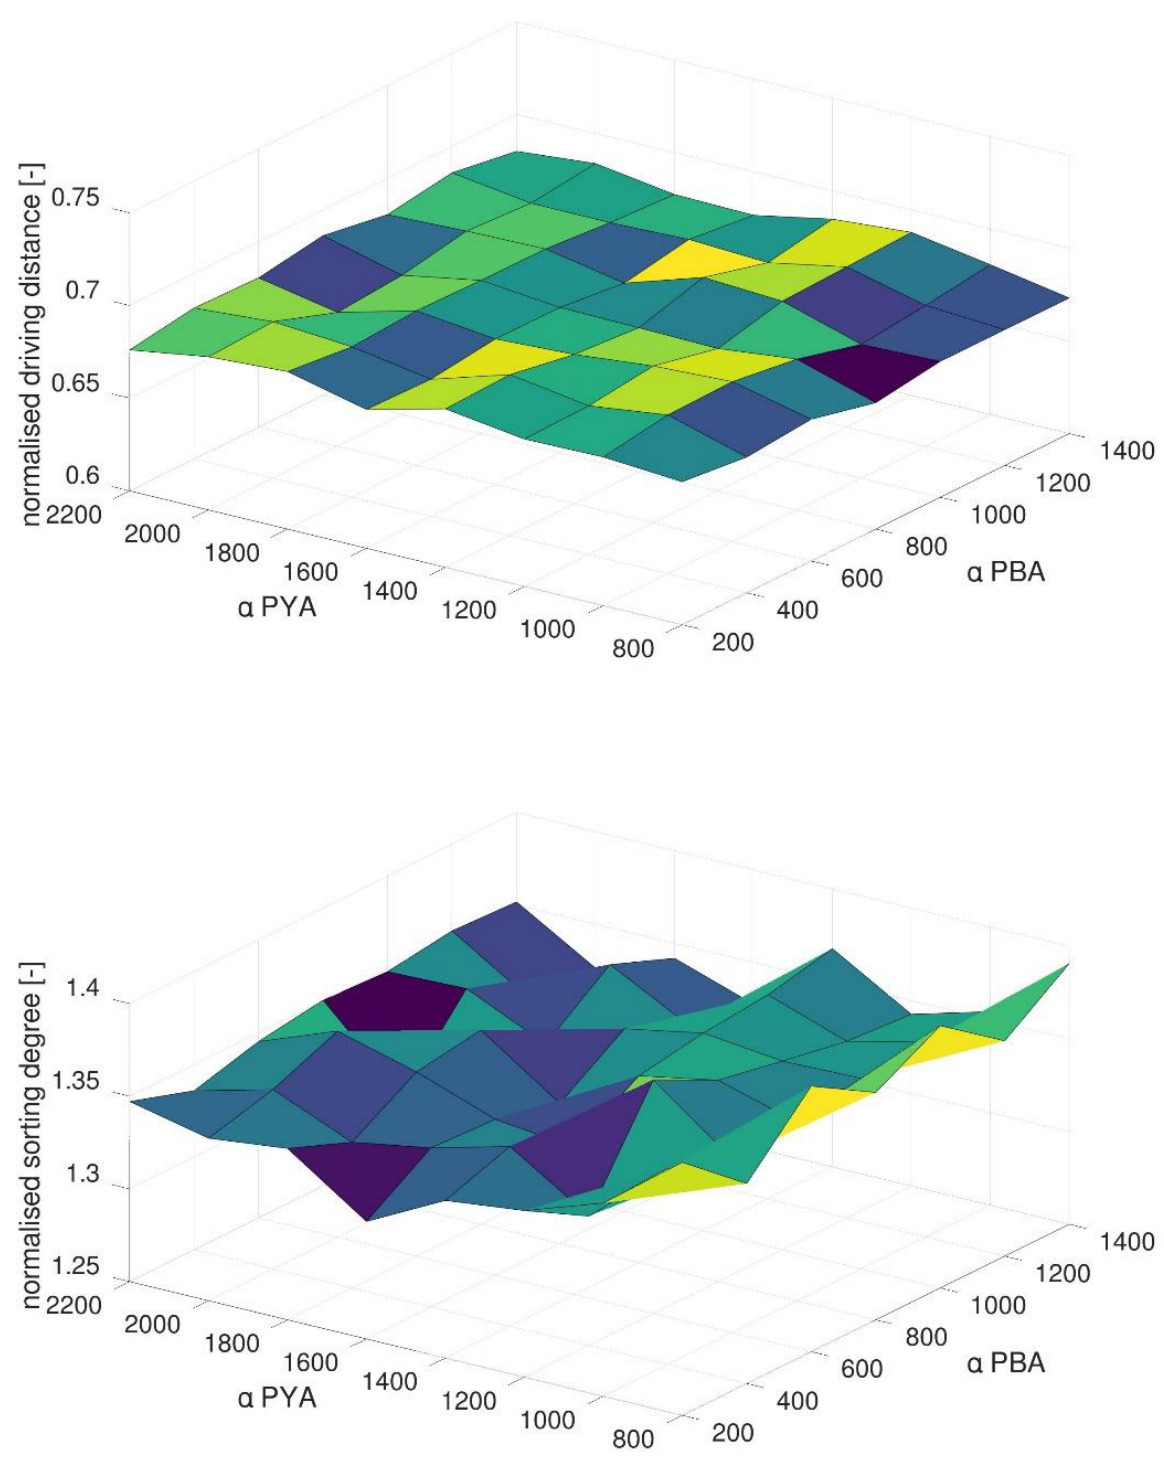
Figure 12. Impact of evaporation constants on normalized terminal